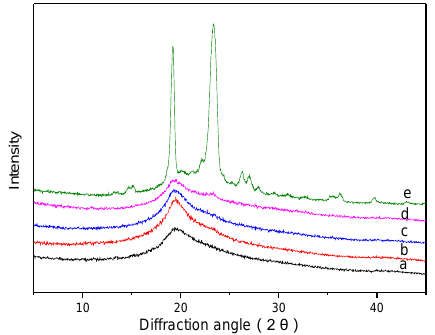
Figure 4. X-ray diffraction of PVA/PEO membranes. ( a ) 8 wt % PVA; ( b ) 8 wt % PVA/3 wt % PEO (90/10); ( c ) 8 wt % PVA/3 wt % PEO (80/20); ( d ) 8 wt % PVA/3 wt % PEO (70/30); ( e ) 3 wt % PEO.